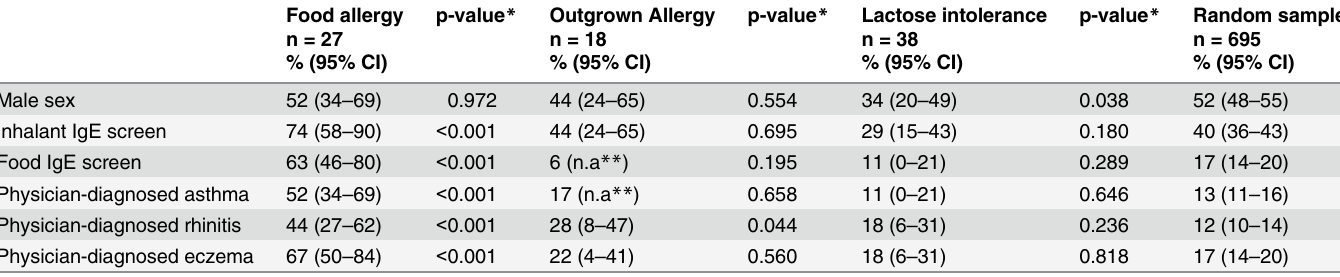
Table 2. Prevalence of the indicated variables in children according to their food hypersensitivity phenotypes compared to the prevalence in a ran- dom sample of children from the entire cohort. Food allergy n =